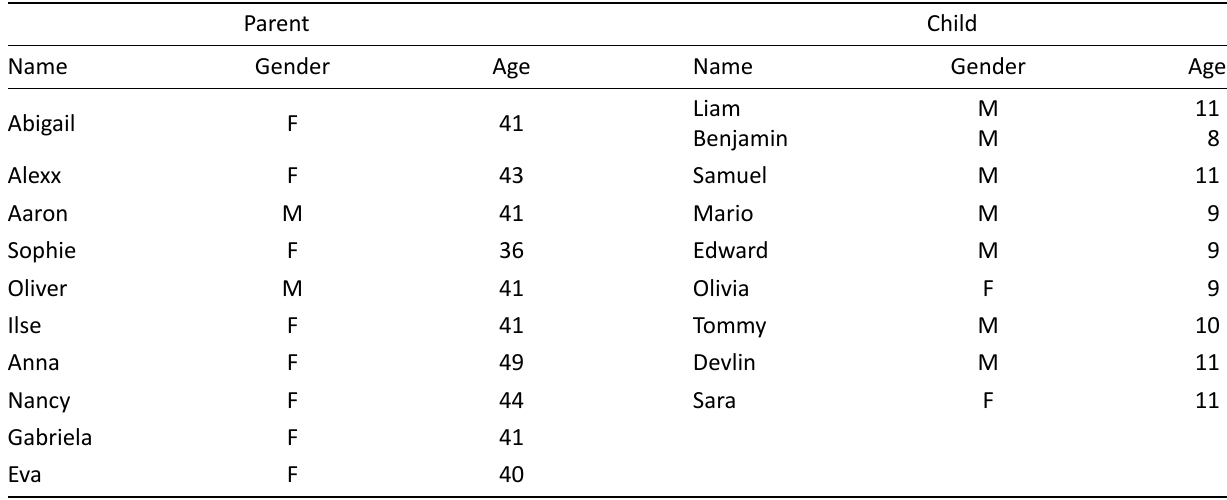
Table 1. Participants’ demographic